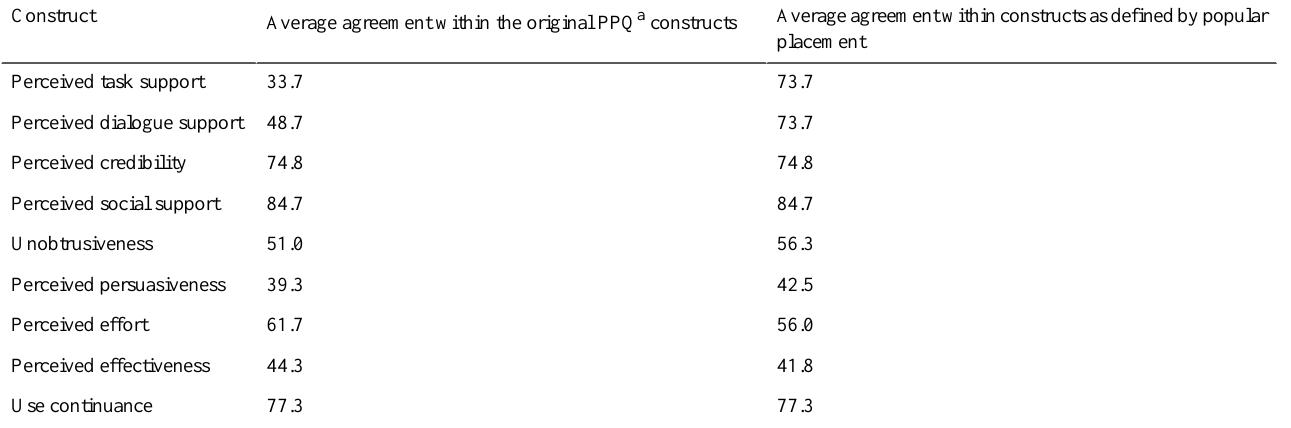
Table 4. Overview of the agreement within the original constructs versus popular placement